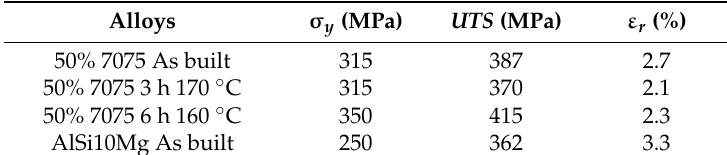
Table 4. Tensile properties of the 50% 7075 samples in different ageing condition compared to the AlSi10Mg ones in the as built state, tested just after shot peening.